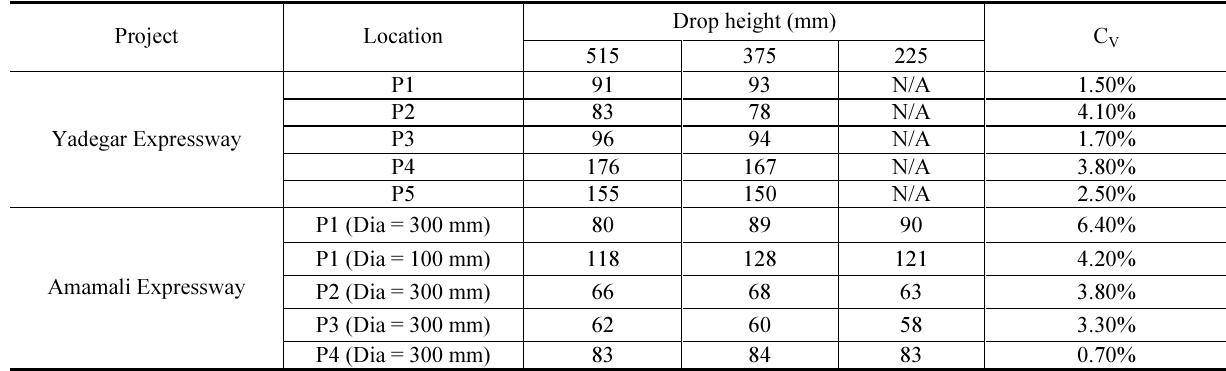
Table 2. The effects of changing the drop height on moduli